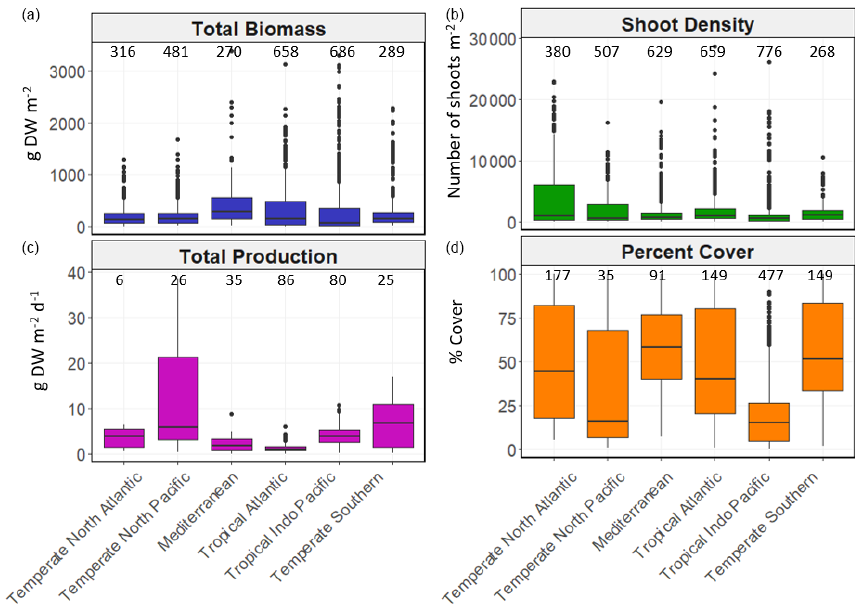
Figure 5. Box-and-whisker plots depicting seagrass total biomass (including above-ground and below-ground biomass; gDWm − 2 ), shoot density (number of shootsm − 2 ), total production (gDWm − 2 d − 1 ) and percent cover (%) values within each bioregion. The box plots show the median value (black line within box), 75% and 25% percentiles create the top and bottom of the box, and the tails are the maximum and minimum contributions within 1.5 interquartile range. Count of data ( N ) per bioregion is shown at the top of each whisker.